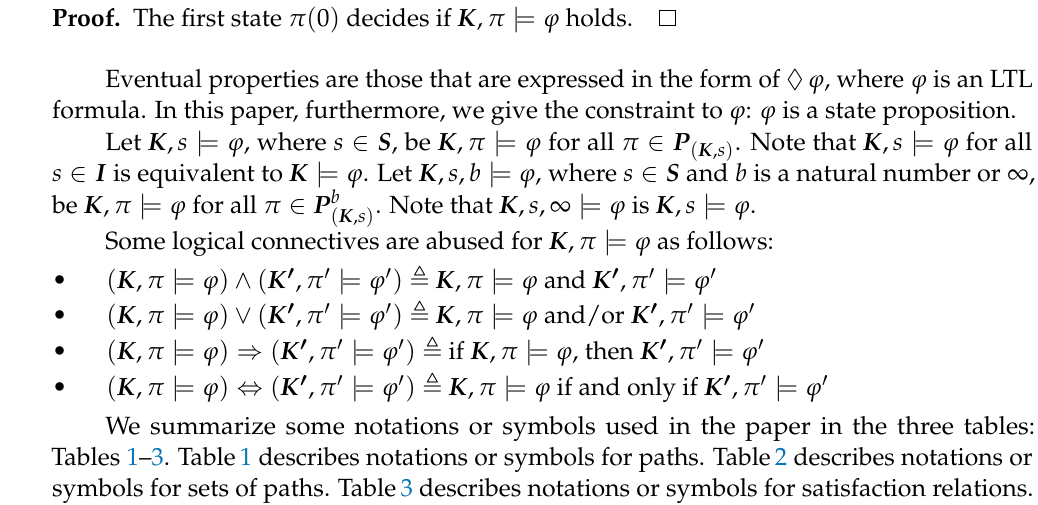
Table 1. Descriptions of path notations (or symbols), where i and j are natural numbers. Symbol Description